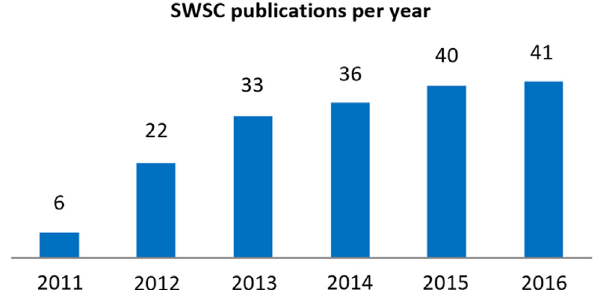
Fig. 2. Number of published articles in SWSC (up to 10 December